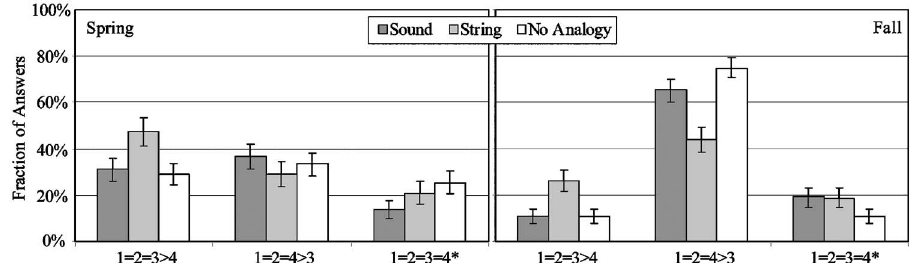
FIG. 4. Post-test results for the initial study (cid:1) spring, left (cid:2) and follow-up study (cid:1) fall, right (cid:2) . The top three answers (cid:1) 1=2=3 (cid:1) 4, 1=2 =4 (cid:1) 3, 1=2=3=4 (cid:2) are shown below the horizontal axis. The analogy groups (cid:1) sound, string, no-analogy (cid:2) are indicated in the legend. Error (cid:4) n (cid:2) . The (cid:1) indicates the bars are the standard error (cid:1) (cid:3) /